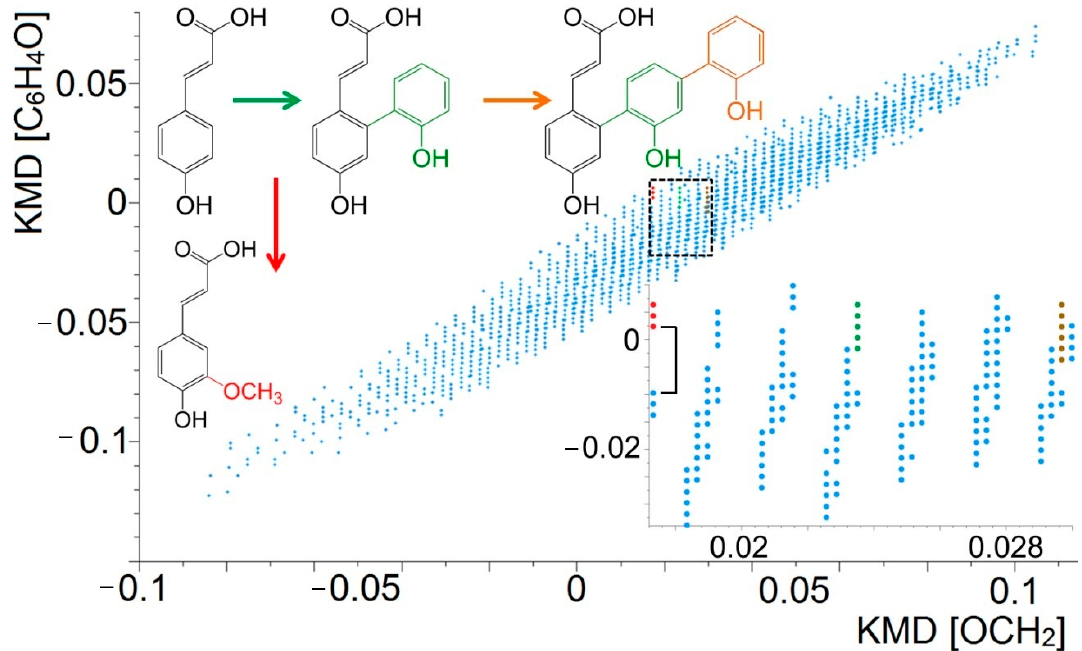
Figure 8. Two-dimensional (2D) mass defect matrix plot for a lignin sample after decomposition. Blue data points represent features in the KMD plot and correspond to degradation products from the sample. The squared area is enlarged (inset) and proposed core structures of the three compound species (red, green, brown) are highlighted in the expanded plot. Reprinted from Qi et al., with permission from Springer Publishing [69].